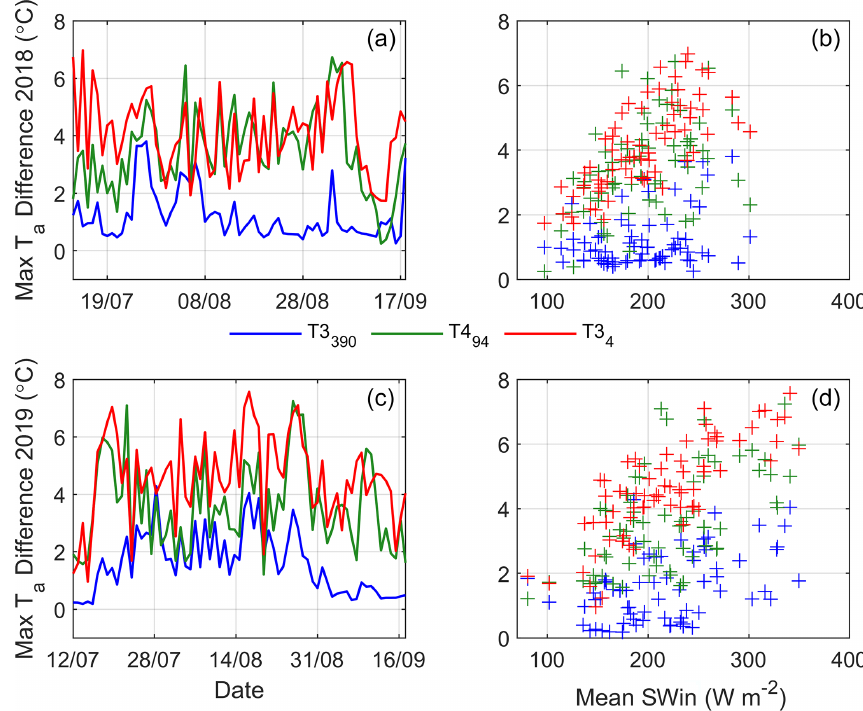
Figure 7. Maximum daily T a differences ( T a Amb – observed) at the T logger closest to the terminus on each glacier for 2018 (a, b) and 2019 (c, d) . Maximum daily T a differences are plotted against mean daily incoming shortwave radiation (SWin) at AWS_Off in panels (b) and (d)